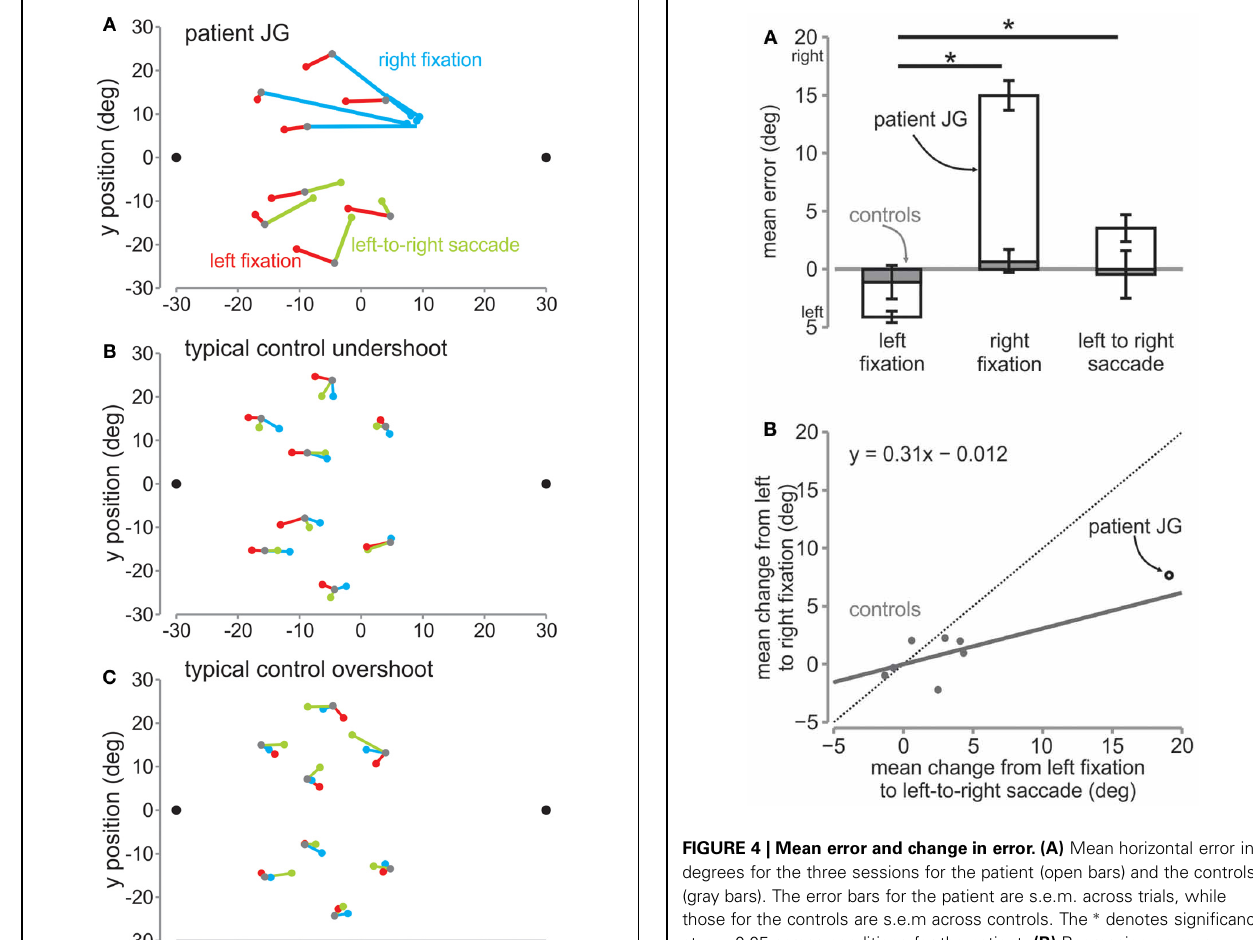
the left-to-right saccade condition ( − 0 . 58 ◦ ) were intermediate between the left ( − 1 . 12 ◦ ) and right (0.66 ◦ ) fixation, however they were not significantly different from right fixation [ t ( 6 ) = 1 . 47,